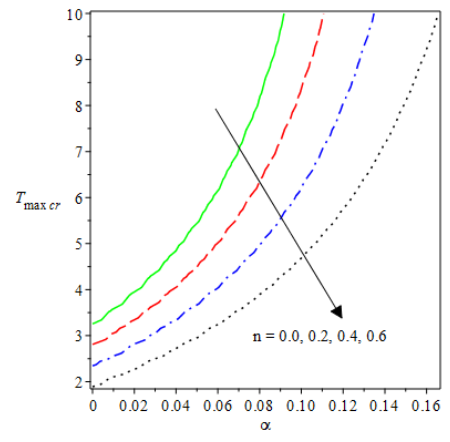
Figure 17. Branch-chain for increasing ( m ) .